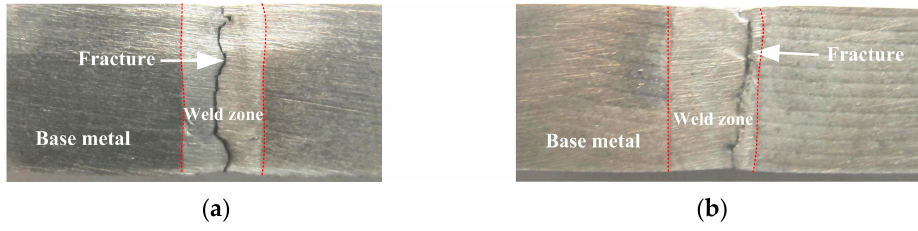
Figure 14. Fracture tensile samples of ( a ) autogenous laser welding; and ( b ) PCALW. Figure 15. ( a ) Fracture surface morphology of the PCALW welded joint; and ( b ) EDS results of the particle.